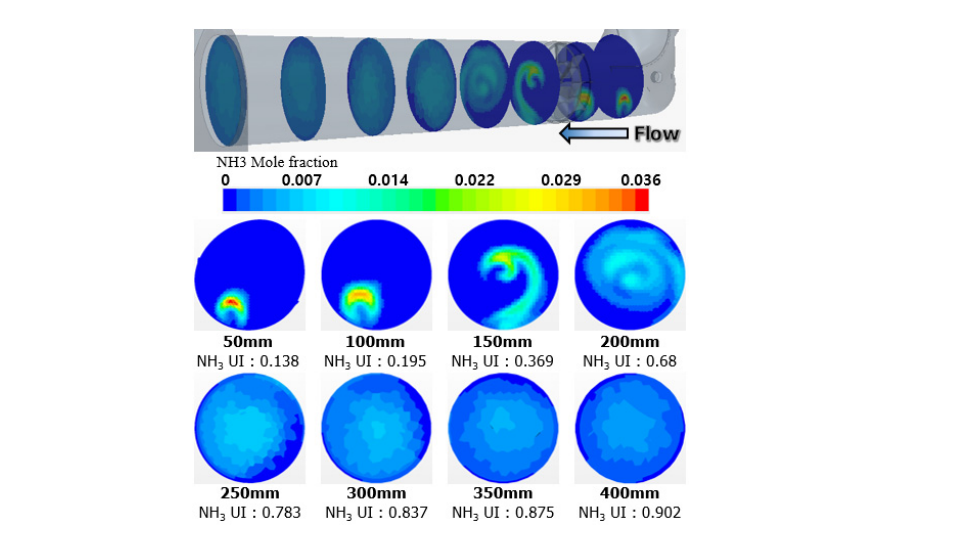
Figure 9. Development of turbulence after a urea injection point and the kinetic energies at specific distances: from 50 mm to 400 mm with 50 mm intervals.